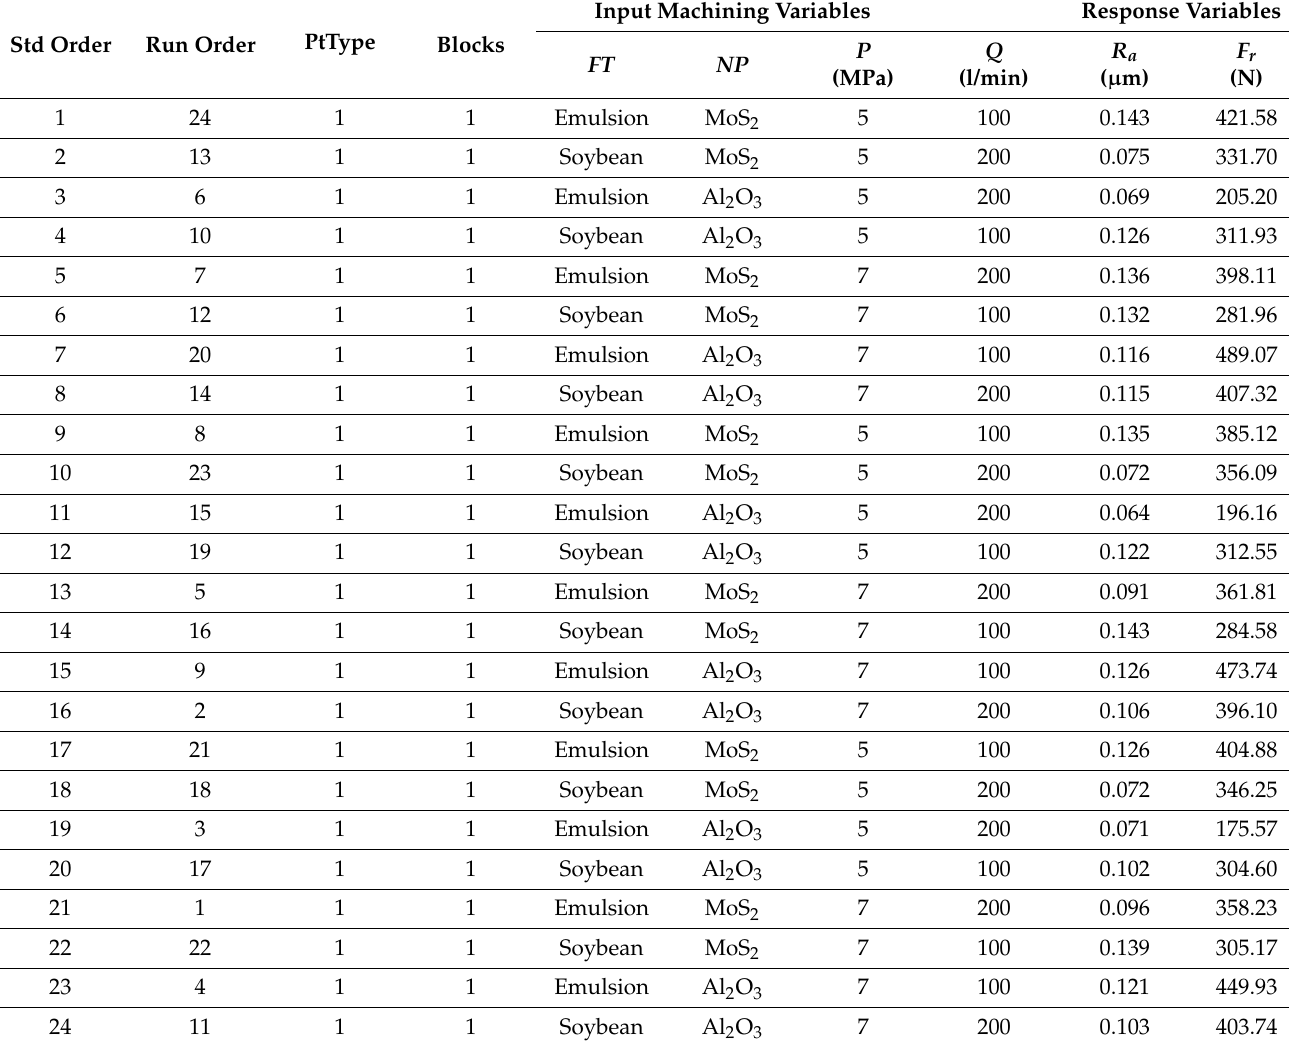
Table 2. The experiment design with test run order and the measured values of surface roughness and cutting force.